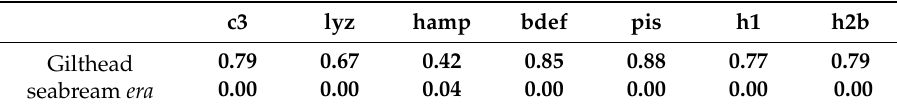
Table 4. Correlations observed between the gene expression of era gene and several AMP-coding genes in gilthead seabream testis after in vivo infection with NNV. The first line corresponds to Pearson coefficient of correlation and the second to the p value. Written in bolds are the parameters correlated. c3 , complement component 3; lyz , lysozyme; hamp , hepcidin; bdef , β -defensin; pis , piscidin; h1 , histone 1; h2b , histone 2B; era , estrogen receptor